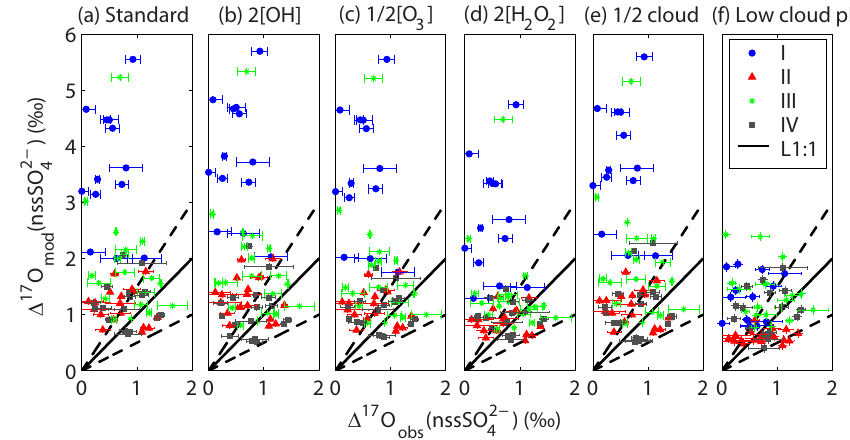
) vs. (cid:49) 17 O obs ( nssSO 2 − ) for different model simulations: (a) standard run, (b) double OH Figure 3. (cid:49) 17 O mod ( nssSO 2 − 4 4